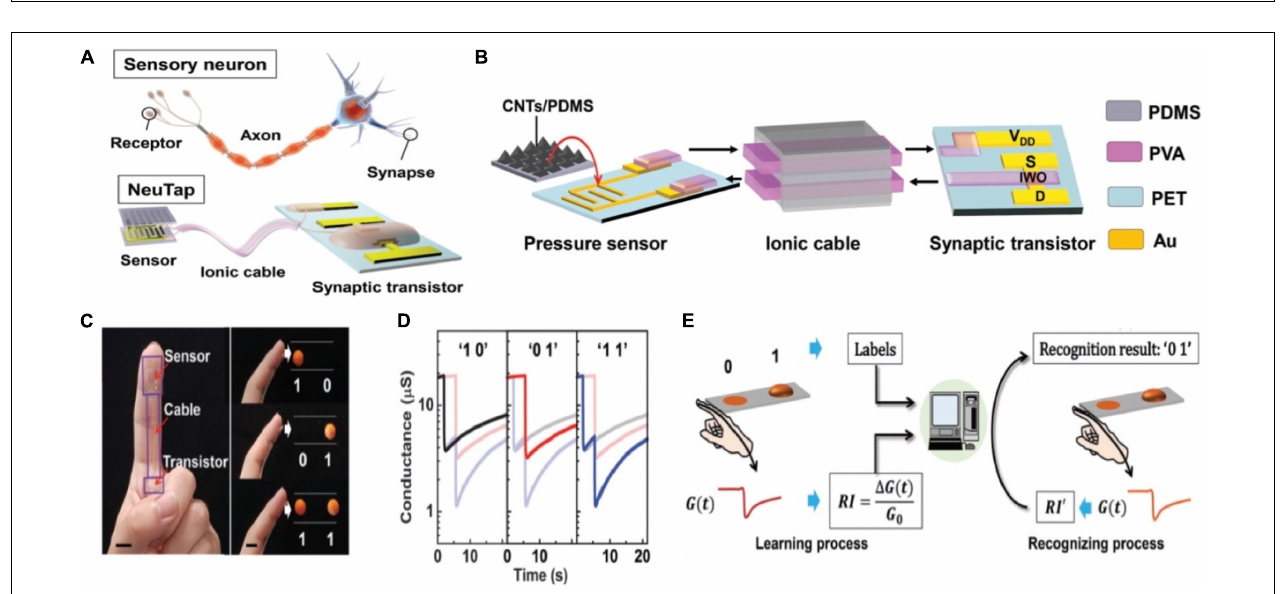
FIGURE 17 | (A) Explanation of the biological concept of motions (left) and the corresponding bionic motion memory device (right). (B) Schematic diagram of the specific structure of the device. (C) I–V curve of the Ag/ZIF-8/Au device (insert: structure of the device). (D) The equivalent electrical circuit of the motion memory system (left), and the detecting and storing information function of the system on elbow flexion (right) (adapted from Liu et al., 2017).